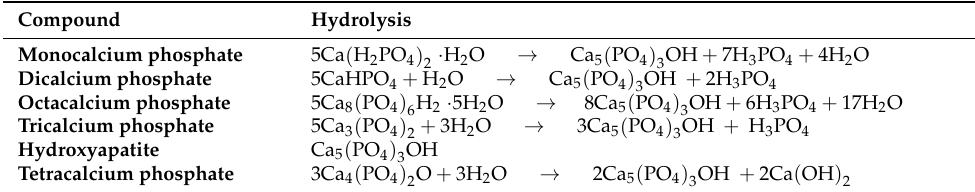
Table 3. The hydrolysis of calcium phosphate compounds